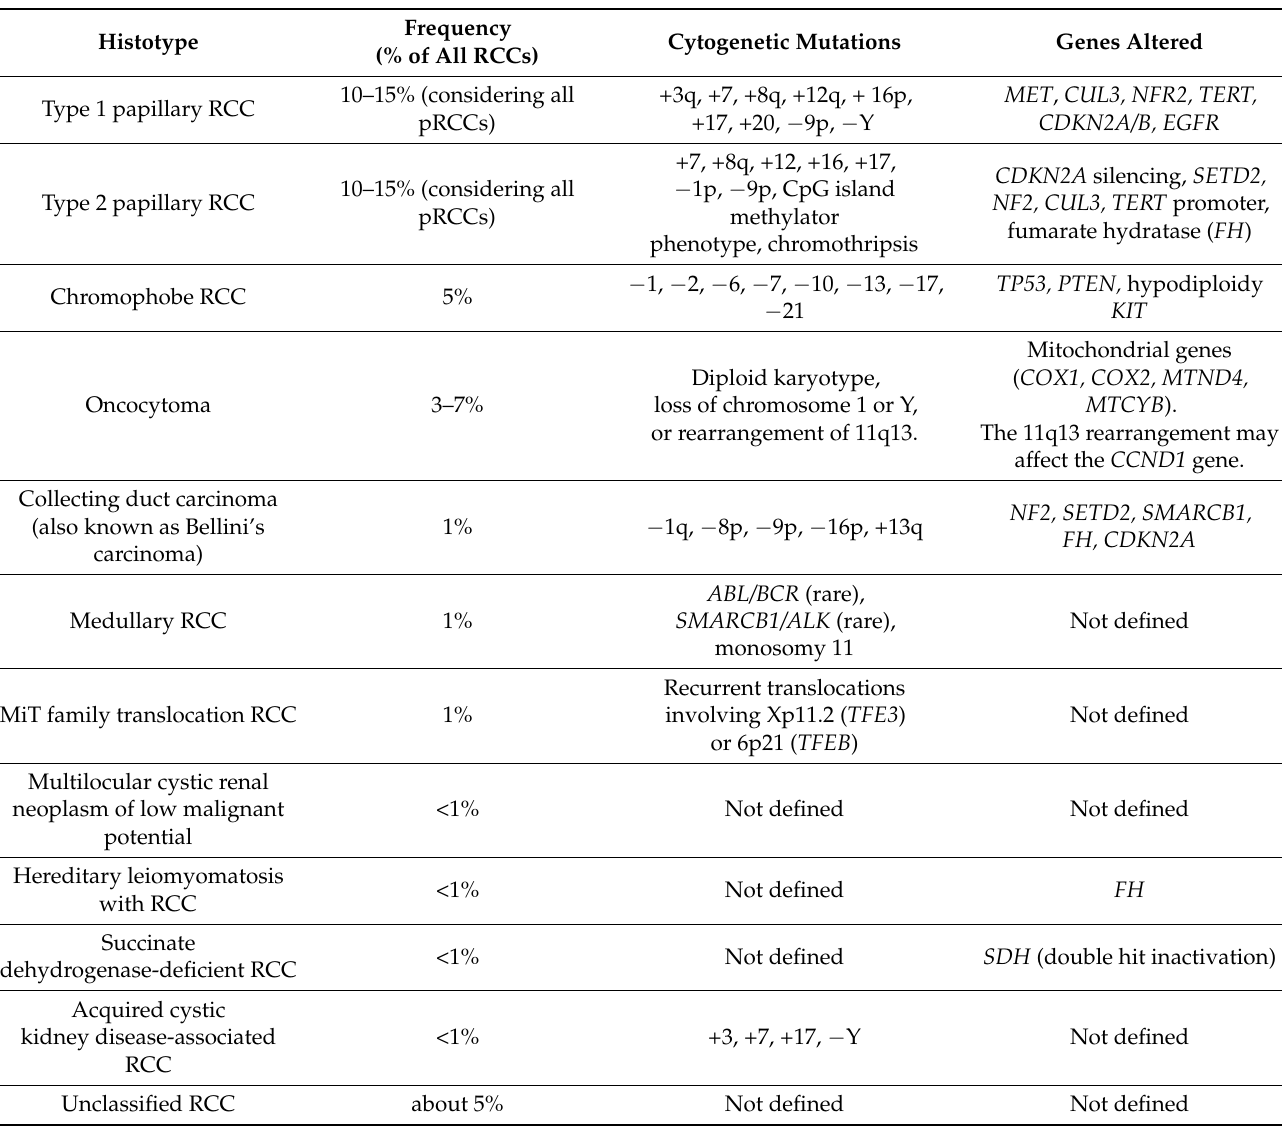
Table 1. Histotypes categorized as non-clear cell renal cell carcinoma (nccRCC) along with their epidemiological features and genetic